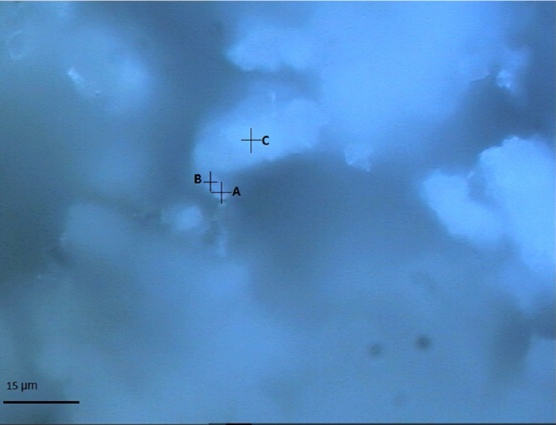
Figure 4. Light optical micrograph showing the selected testing area and points (A–C) in chloride attacked SF–PC sample.